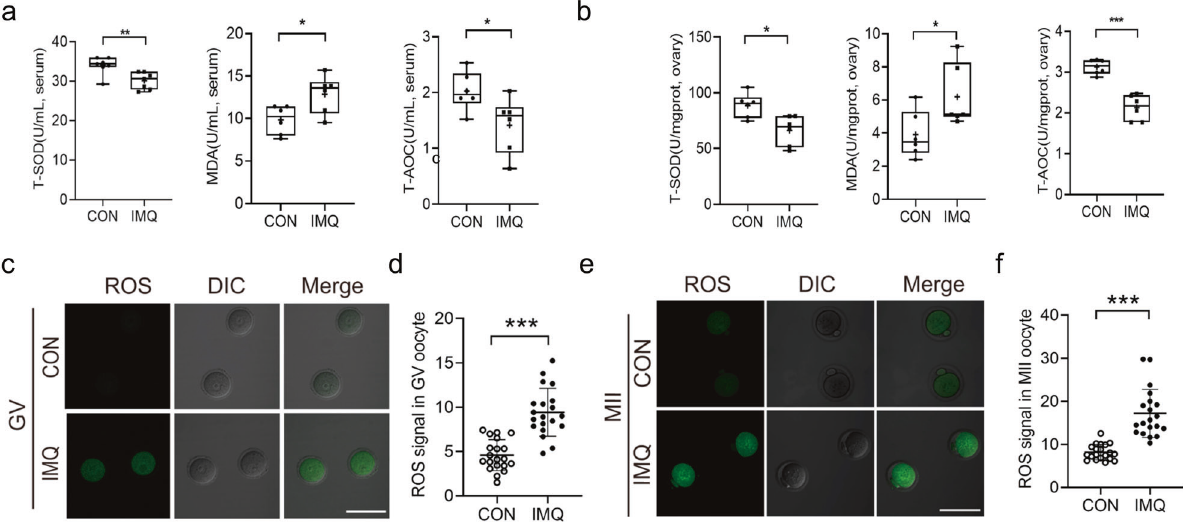
Fig. 4 Effects of psoriasis-like symptoms on the serum and ovarian antioxidant capacity ability and oocyte ROS generation. a The T-SOD, MDA, and T-AOC levels in the serum from IMQ and CON groups. b The T-SOD, MDA, and T-AOC levels in the ovaries from IMQ and CON groups. n = 6 for each group. In GV and MII oocytes from CON and IMQ groups, ROS levels were assessed by the intensity of the green fl uorescence signal. c Confocal images of ROS signal in GV oocytes from CON and IMQ mice. Scale bar: 150 µm. d Quantitative analysis of green fl uorescence intensity in GV oocytes ( n = 20 for each group). e Confocal images of ROS signal in MII oocytes from CON and IMQ mice. f Quanti fi cation of the ROS levels in MII oocytes ( n = 20 for each group). The data are shown as mean ± SD. * P < 0.05, ** P < 0.01, *** P < 0.001.